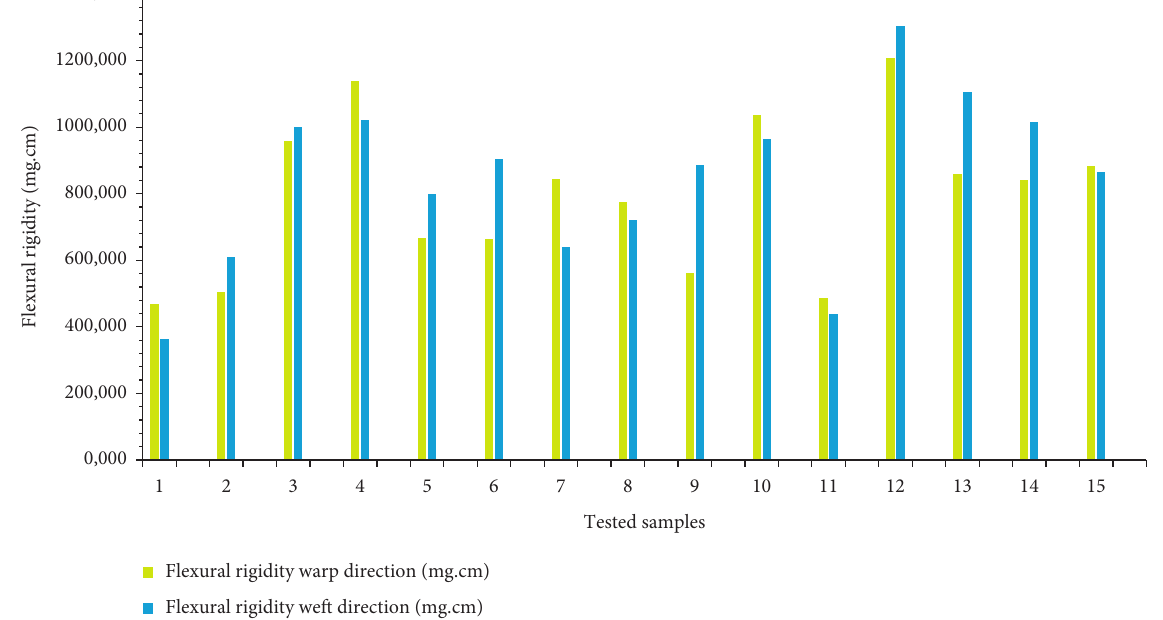
Figure 12: Flexural rigidity behavior for coated samples measured according to warp and weft